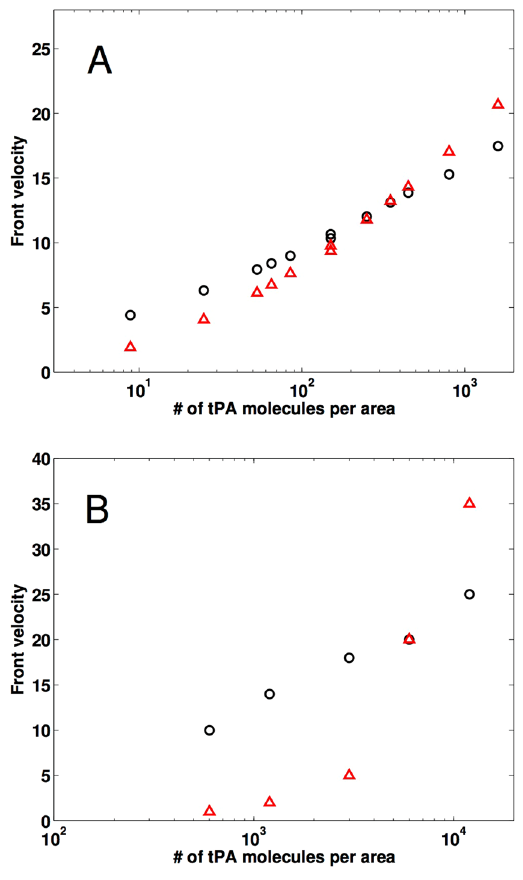
Figure 2. Lysis front velocity as a function of clot structure and tPA concentration. Lysis front velocity, in μ m/ min, of a fine clot (red triangles) and a coarse clot (black circles) as a function of the ratio of the number of tPA molecules to the surface area of clot exposed to the fibrin-free region. ( A ) Mathematical model simulations were run with 11 different tPA-to-surface-area ratios varying from 8 to 1600 molecules/ μ m 2 . Each symbol indicates the mean of ten independent simulations. For a tPA-to-surface-area ratio of 150, a pair of distinct experiments were run for each clot type, one with an 85 nM tPA solution and the other with a 5 nM tPA solution, and the results for each pair were almost the same (as seen by the double symbols). ( B ) Laboratory experiments were run with 5 different tPA-to-surface-area ratios varying from 600 to 12000 molecules/ μ m 2 . Each symbol indicates the mean of three independent trials. Clots were formed from the pooled plasma of 6